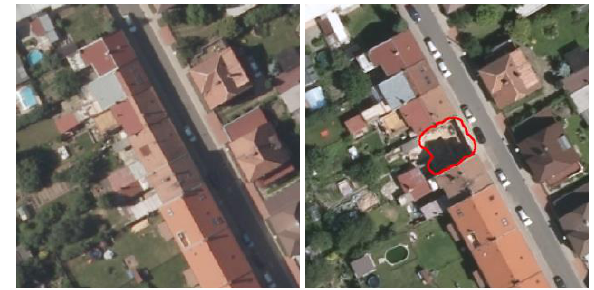
Figure 6. True indication of a demolished building